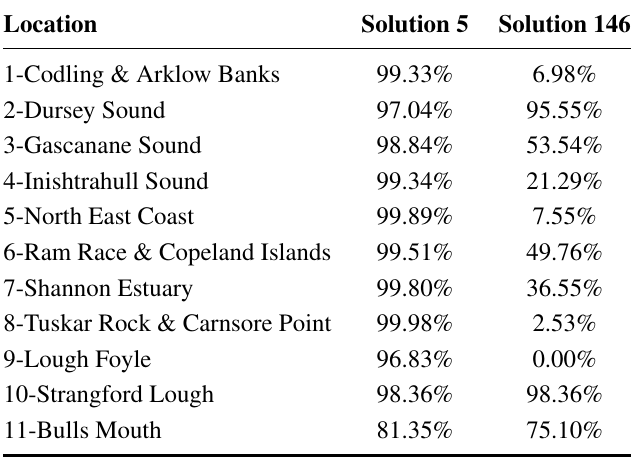
Table 6. Simulation results: extracted energy per year at each location, as fraction of the total available